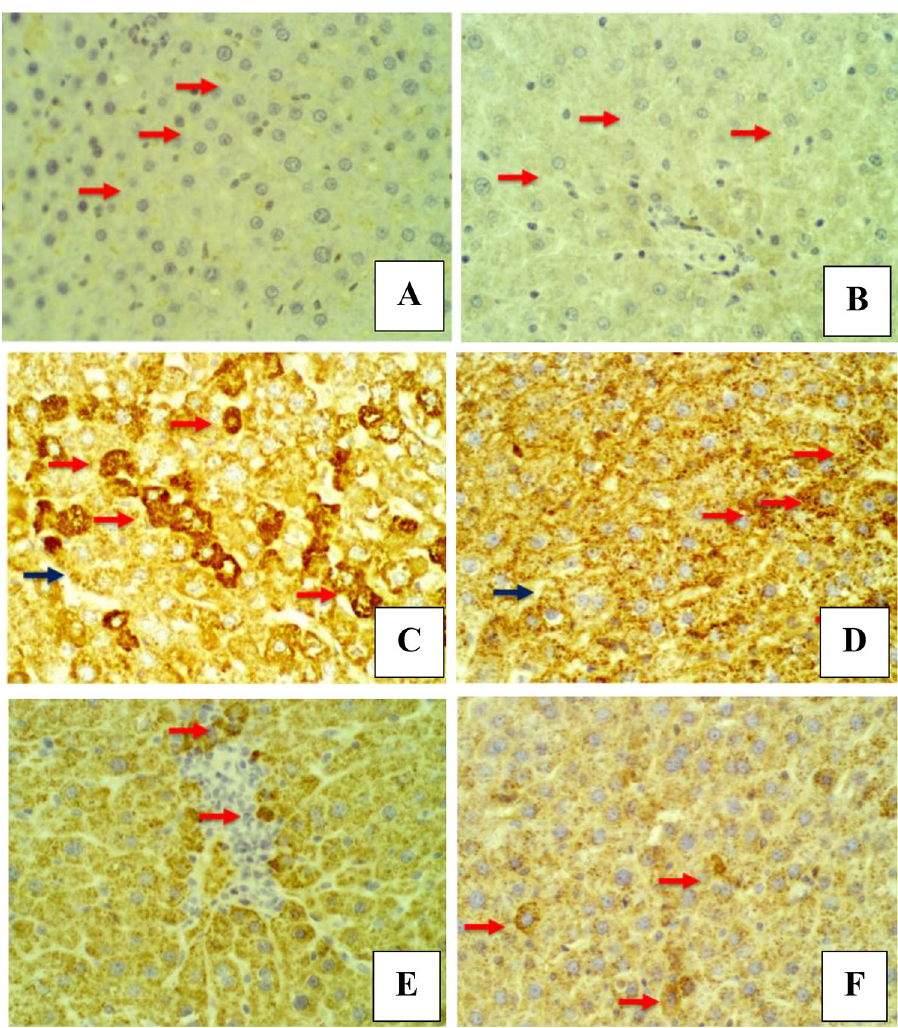
Figure 6. Liver section, IHC HSA -ab. 400×. ( A ) Placebo group/3 weeks, shows negative staining with HSA antibodies in the cytoplasm of hepatocytes (red arrow). ( B ) Placebo group/ 6 weeks, shows negative staining with HSA antibodies in the cytoplasm of hepatocytes (red arrow). ( C ) DEN/3 weeks, shows strong positive staining with HSA antibodies in the affected hepatocytes which stained as cytoplasmic golden brawn granule (red arrow), notice unspecific staining in other hepatocytes (black arrow). ( D ) DEN group/6 weeks, shows strong positive staining with HSA antibodies in the affected hepatocytes which stained as cytoplasmic golden brawn granule (red arrow). ( E ) 5B2T group/3 weeks, shows few weakly positive staining with HSA antibodies in the cytoplasm of hepatocytes as golden brown granules (red arrow). ( F ) 5B2T group/6 weeks, shows few weakly positive staining with HSA antibodies in the cytoplasm of hepatocytes as golden brown granules (red arrow).